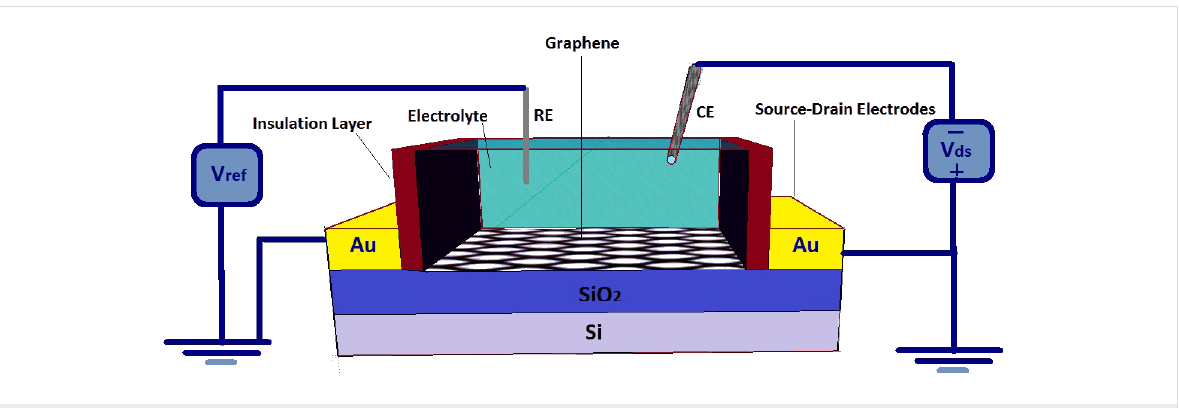
Figure 1: A schematic of a graphene-based EGFET including the bias configuration (three-electrode electrochemical cell).